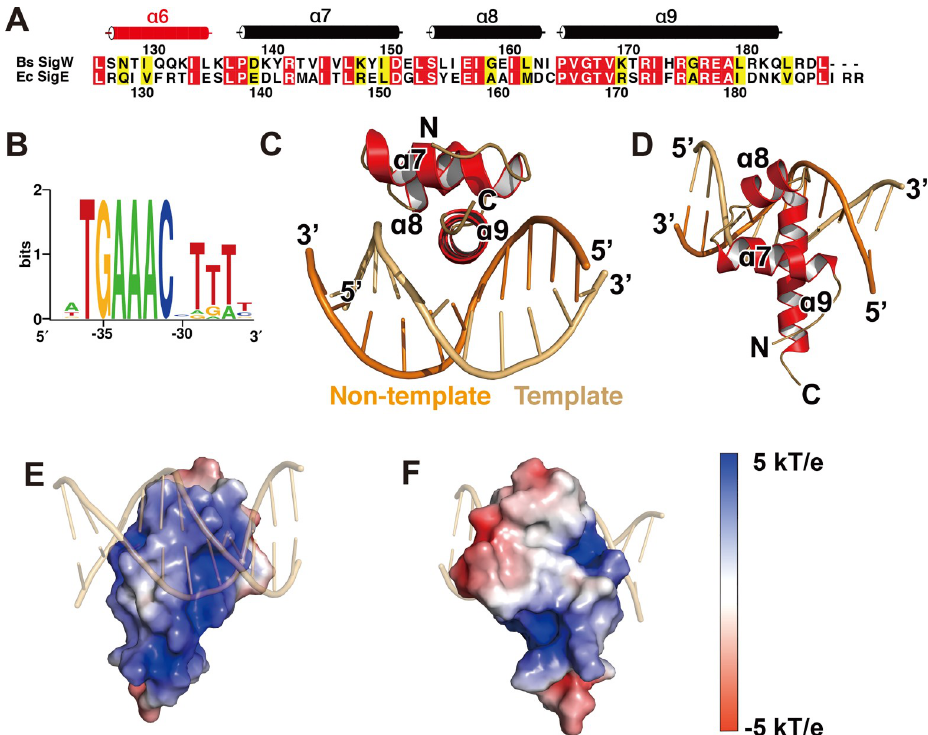
Fig 1. Structure of the σ W 4 /-35 W complex. (A) Sequence alignment of σ W 4 and σ E 4 . The secondary structure of the σ W 4 domain is displayed using a tube to indicate an α -helix. Identical residues are boxed in red, and similar residues are boxed in yellow. α 6 disordered in the structure is displayed as a red tube, based on the crystal structure of the SigW/RsiW complex (PDB ID: 5WUQ). (B) Sequence logo for the -35 promoter element of the SigW regulon [44]. (C, D) Ribbon models of the σ W 4 /-35 W complex, drawn at two different orientations. α 9 of σ W 4 is inserted into the major groove of -35 W as a recognition helix of the HTH motif. (E, F) Surface model of σ W 4 with charge distribution. The electrostatic potential, from red (-5 kT/e) to blue (+5 kT/e), is plotted on the solvent-accessible surface calculated with a solvent probe radius of 1.4 Å